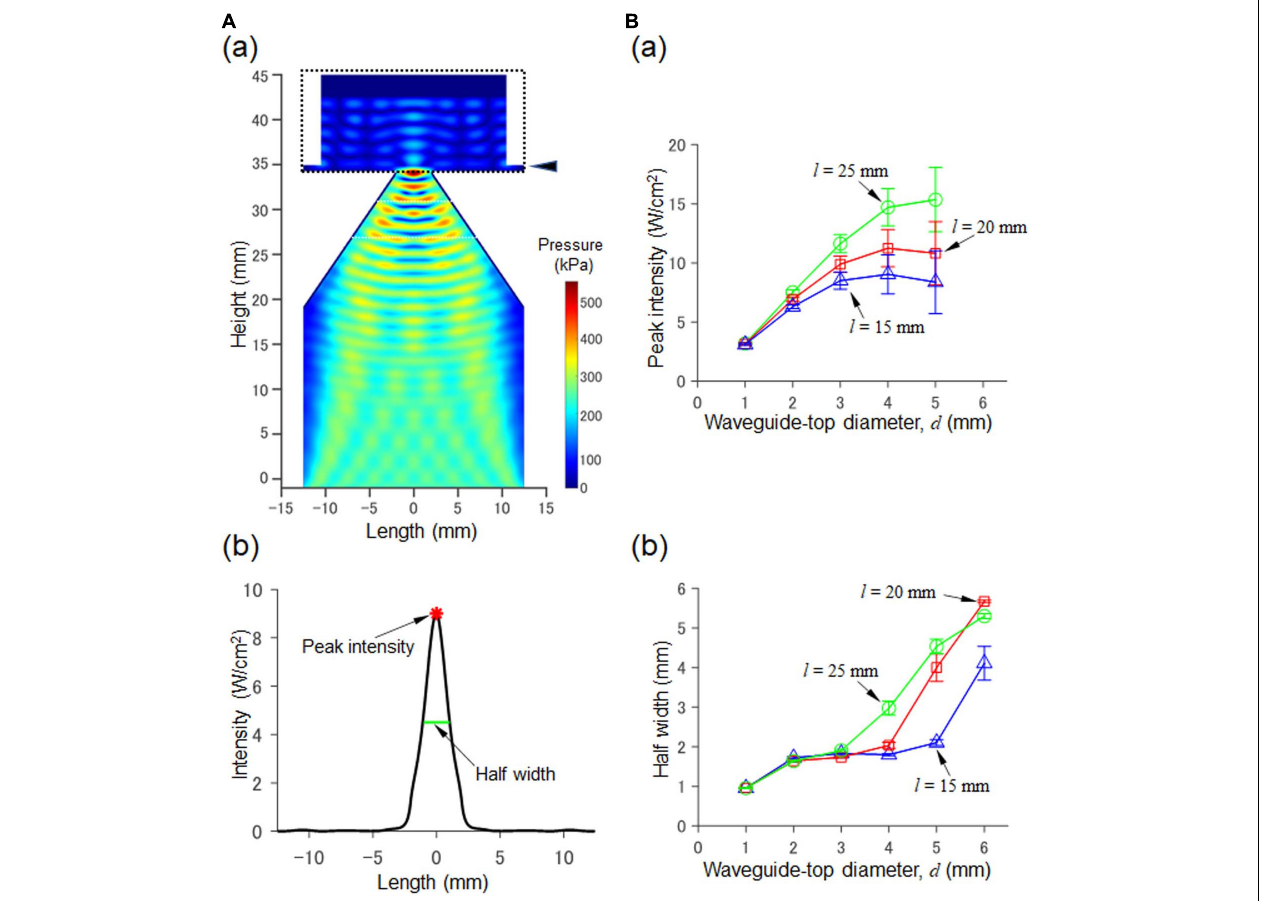
FIGURE 2 | Numerical simulation of a 2D model consisting of a waveguide and an MEA probe. (A) In (a), the acoustic pressure distribution in the cross section passing through the central axis. The size parameters are d = 4.0 mm and l = 20 mm ( Figure 1Aa ). In (b), for the cross section at a height of 35.7 mm in (a) (indicated by the arrowhead on the upper right), the corresponding intensity ( I sppa ) calculated from the pressure is shown. In the plot, the peak intensity (red asterisk) and the halfwidth (green line) of the pressure are also indicated by arrows. (B) In (a), the results of our numerical simulation with respect to the relationship between the diameter d and peak intensity ( I sppa ) are summarized for fixed three values of l (i.e., l = 15, 20, and 25 mm; height 35.7 mm as in (a)). In (b), the relationship between the diameter d and the half width is illustrated for the three fixed